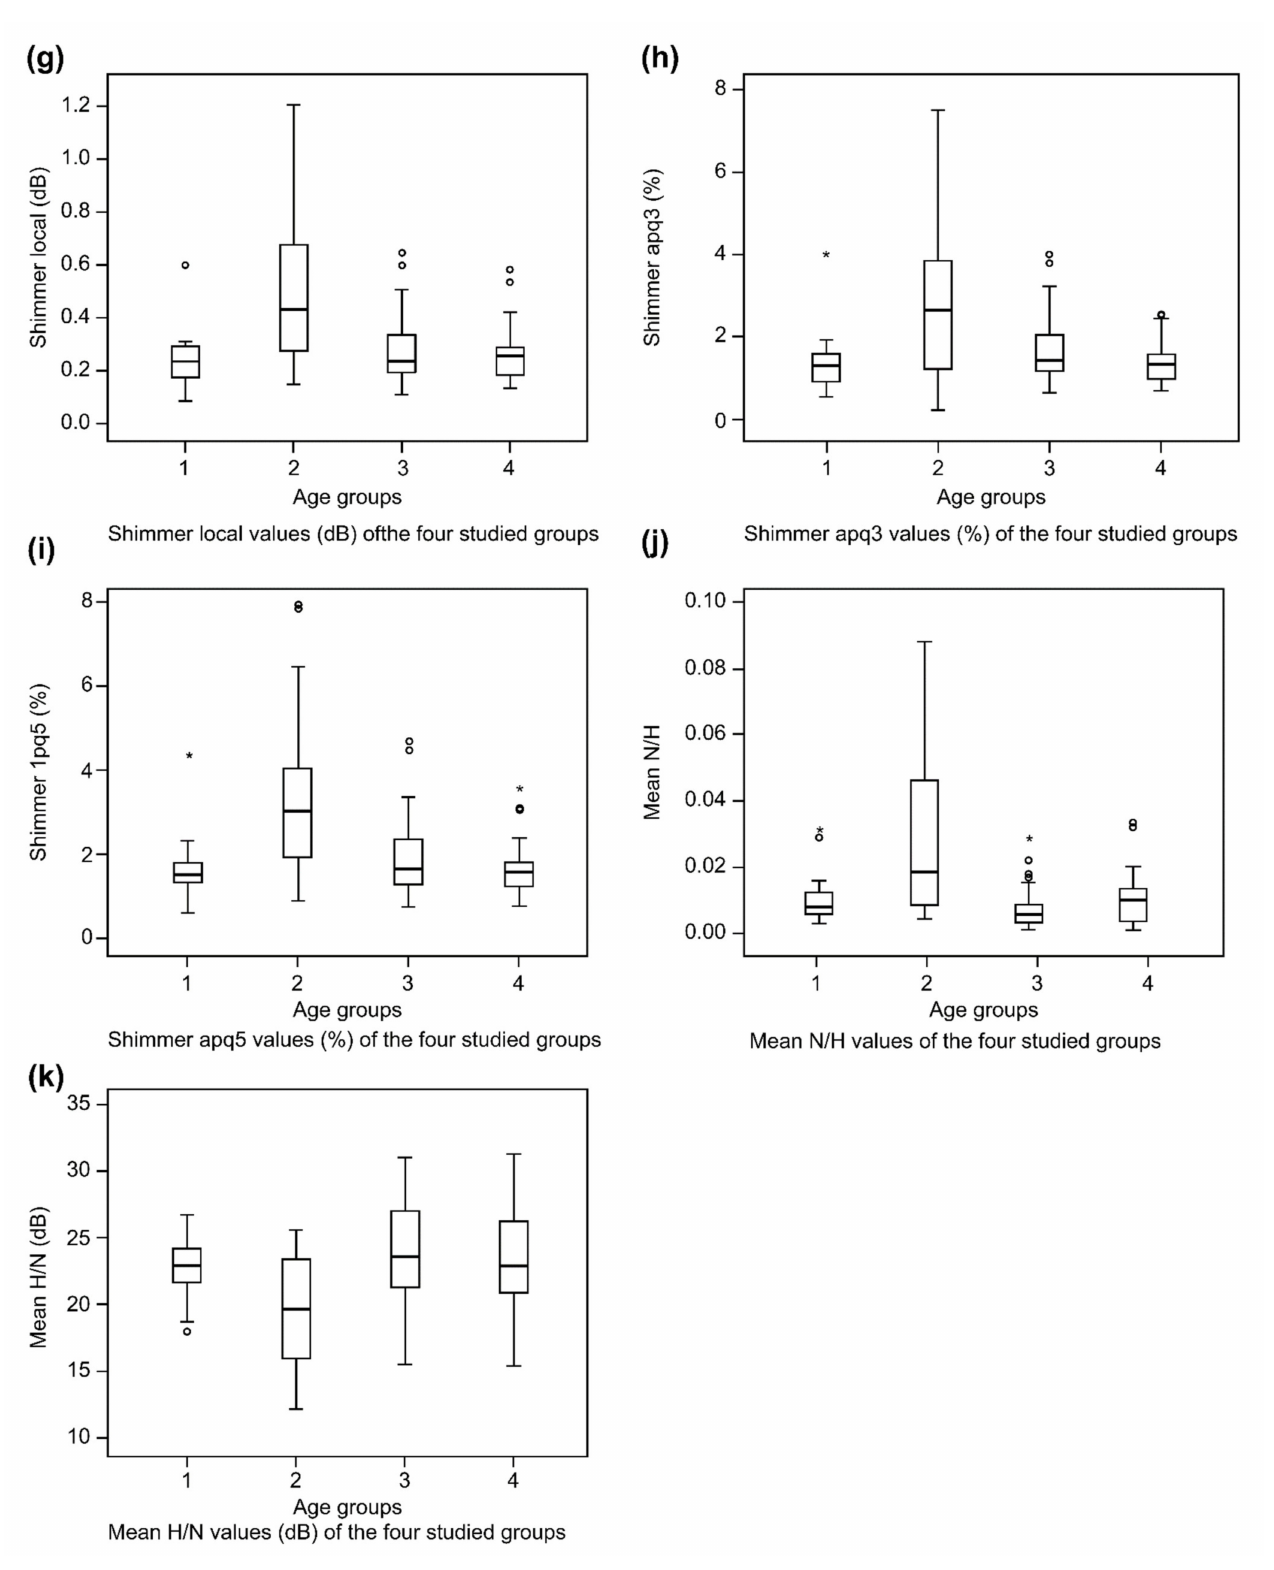
Figure 1. Distributions of acoustic parameters analyzed with